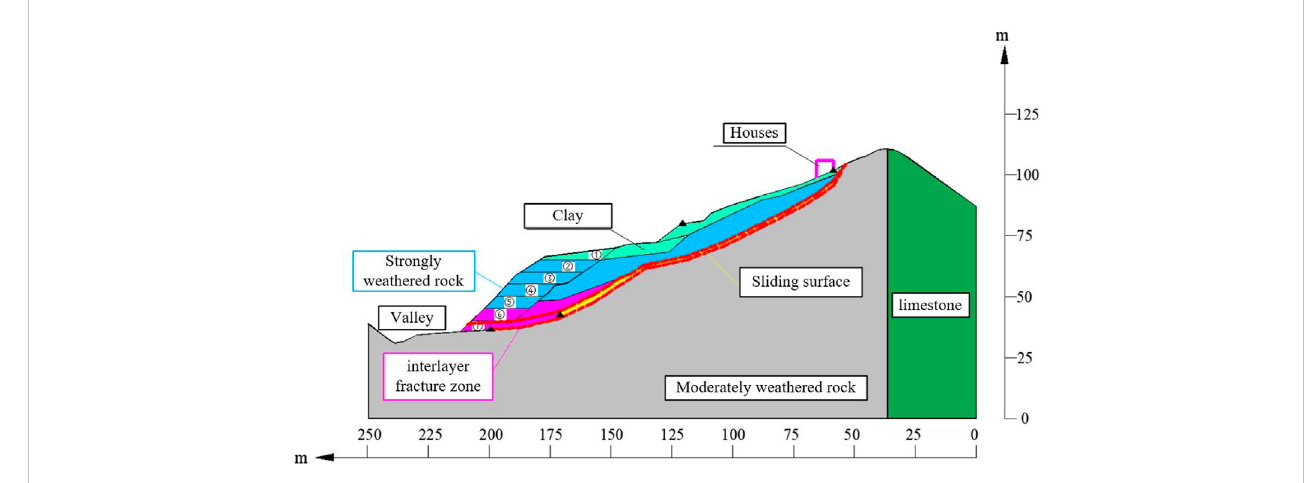
FIGURE 8 Numerical simulation model of the study case.